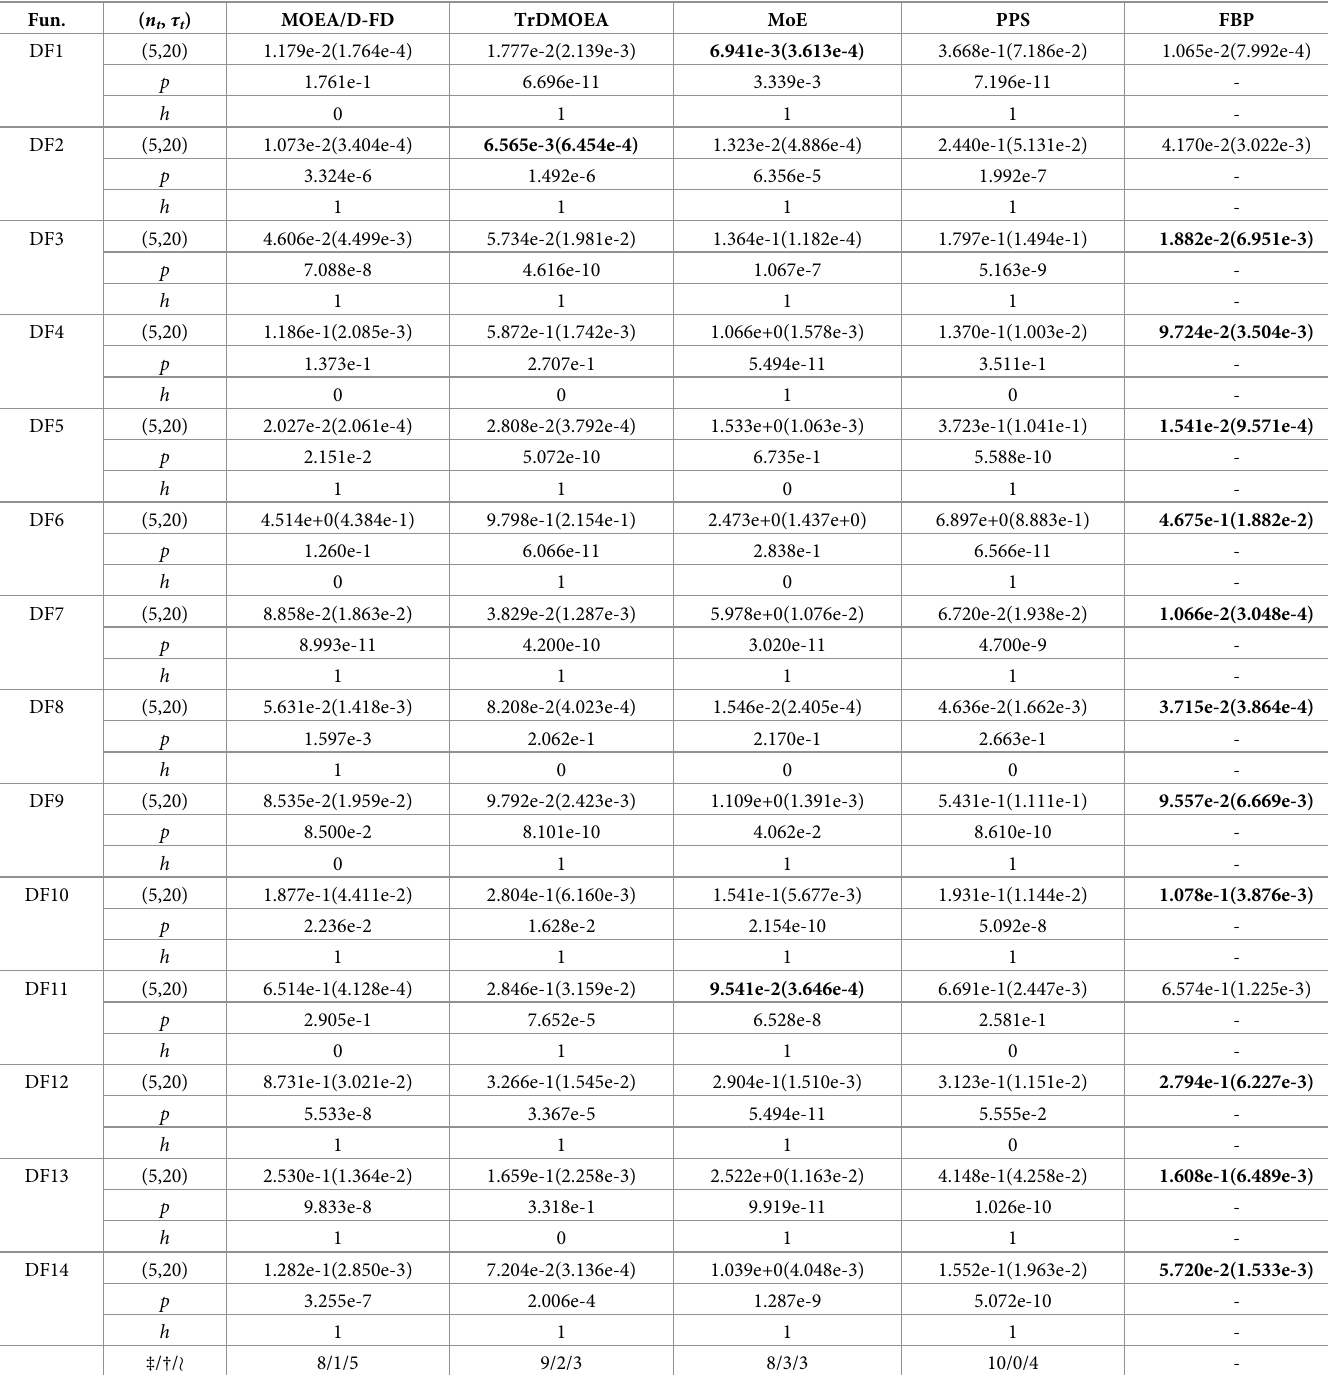
Table 1. Mean and standard deviation values of MIGD obtained by five algorithm for ( n t , τ t ) = (5,20).